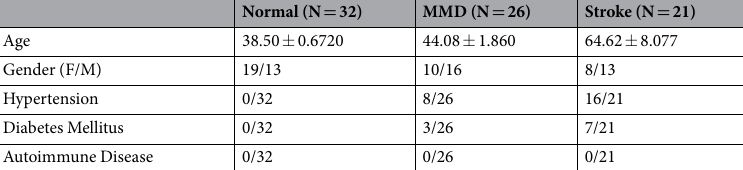
Table 1. Clinical characteristics of control group, MMD and atherothrombotic stroke.